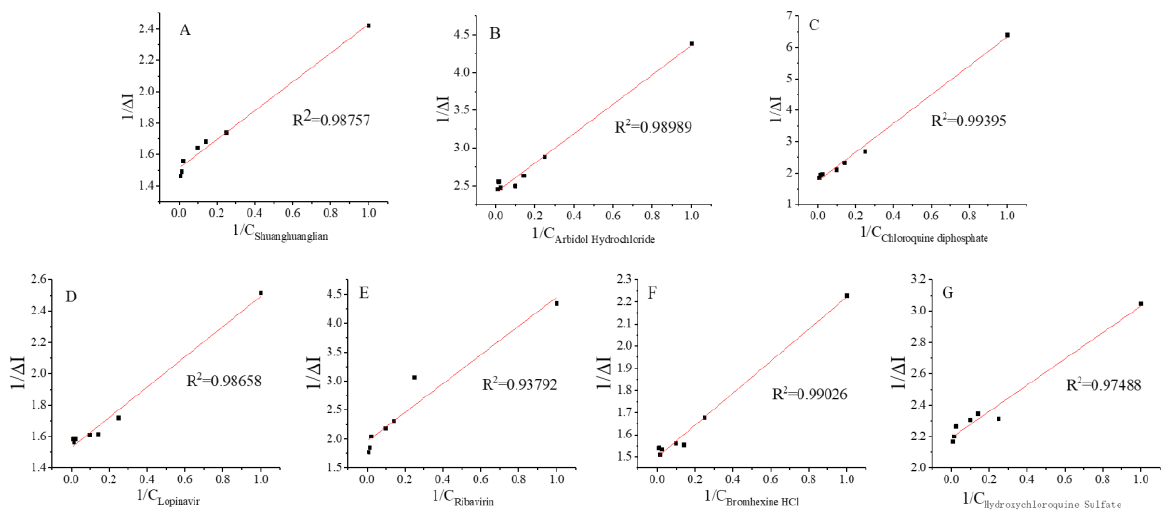
Figure 7. Double reciprocal plots of the fitted response curves of ( A ) Shuanghuanglian oral liquid 10 − 20 –10 − 18 mol/L; ( B ) abridol 10 − 20 –10 − 18 mol/L; ( C ) chloroquine diphosphate 10 − 19 –10 − 17 mol/L; ( D ) lopinavir 10 − 19 –10 − 17 mol/L; ( E ) ribavirin 10 − 19 –10 − 17 mol/L; ( F ) bromhexine 10 − 21 – 10 − 19 mol/L; and ( G ) hydroxychloroquine 10 − 14 –10 − 12